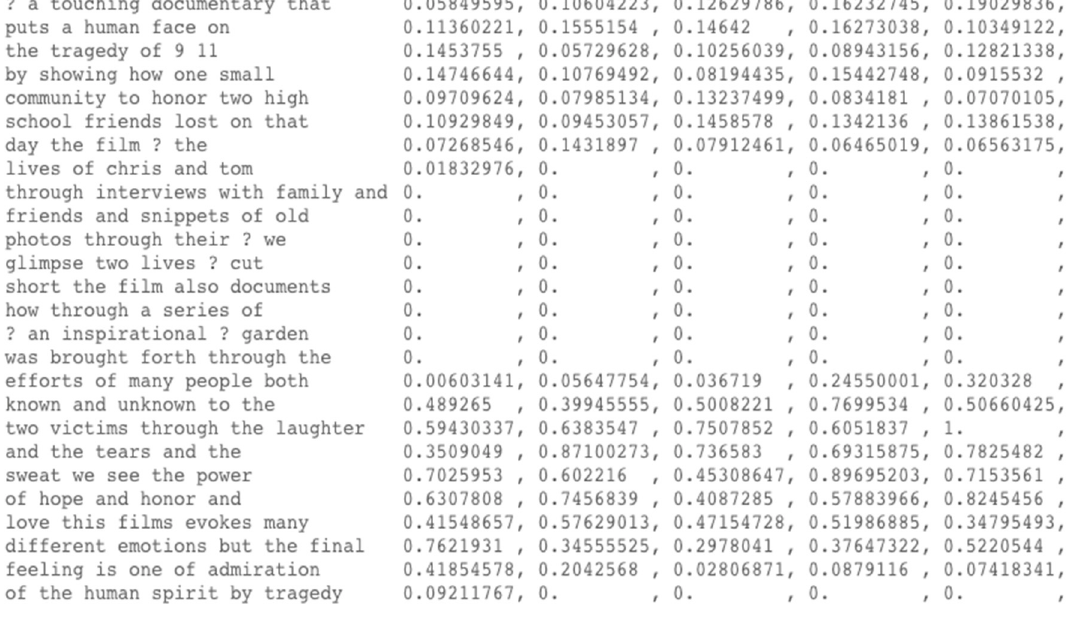
Figure 8. Comment number 14_8 and the weight matrix.